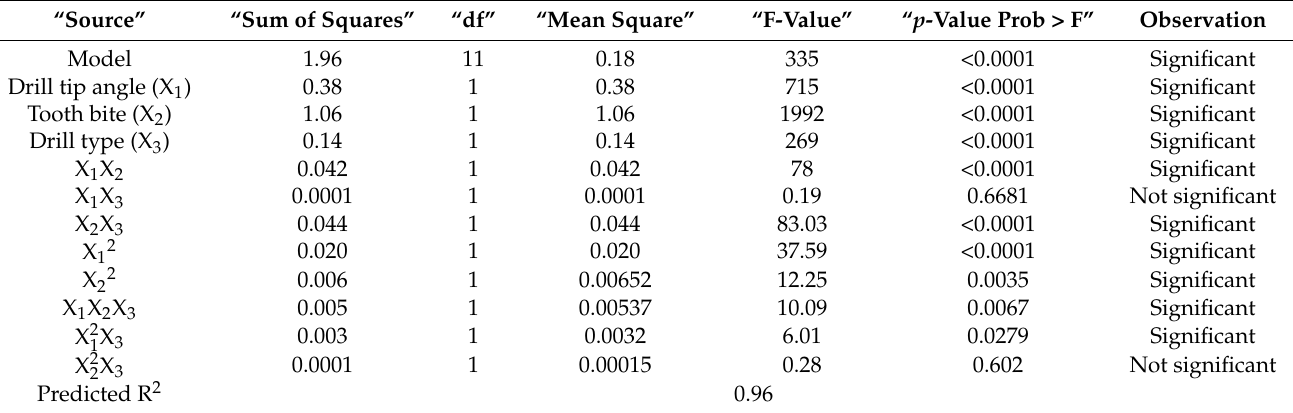
The 3D plots showing the interaction effects of drill tip angle (X 1 ) and tooth bite (X 2 )